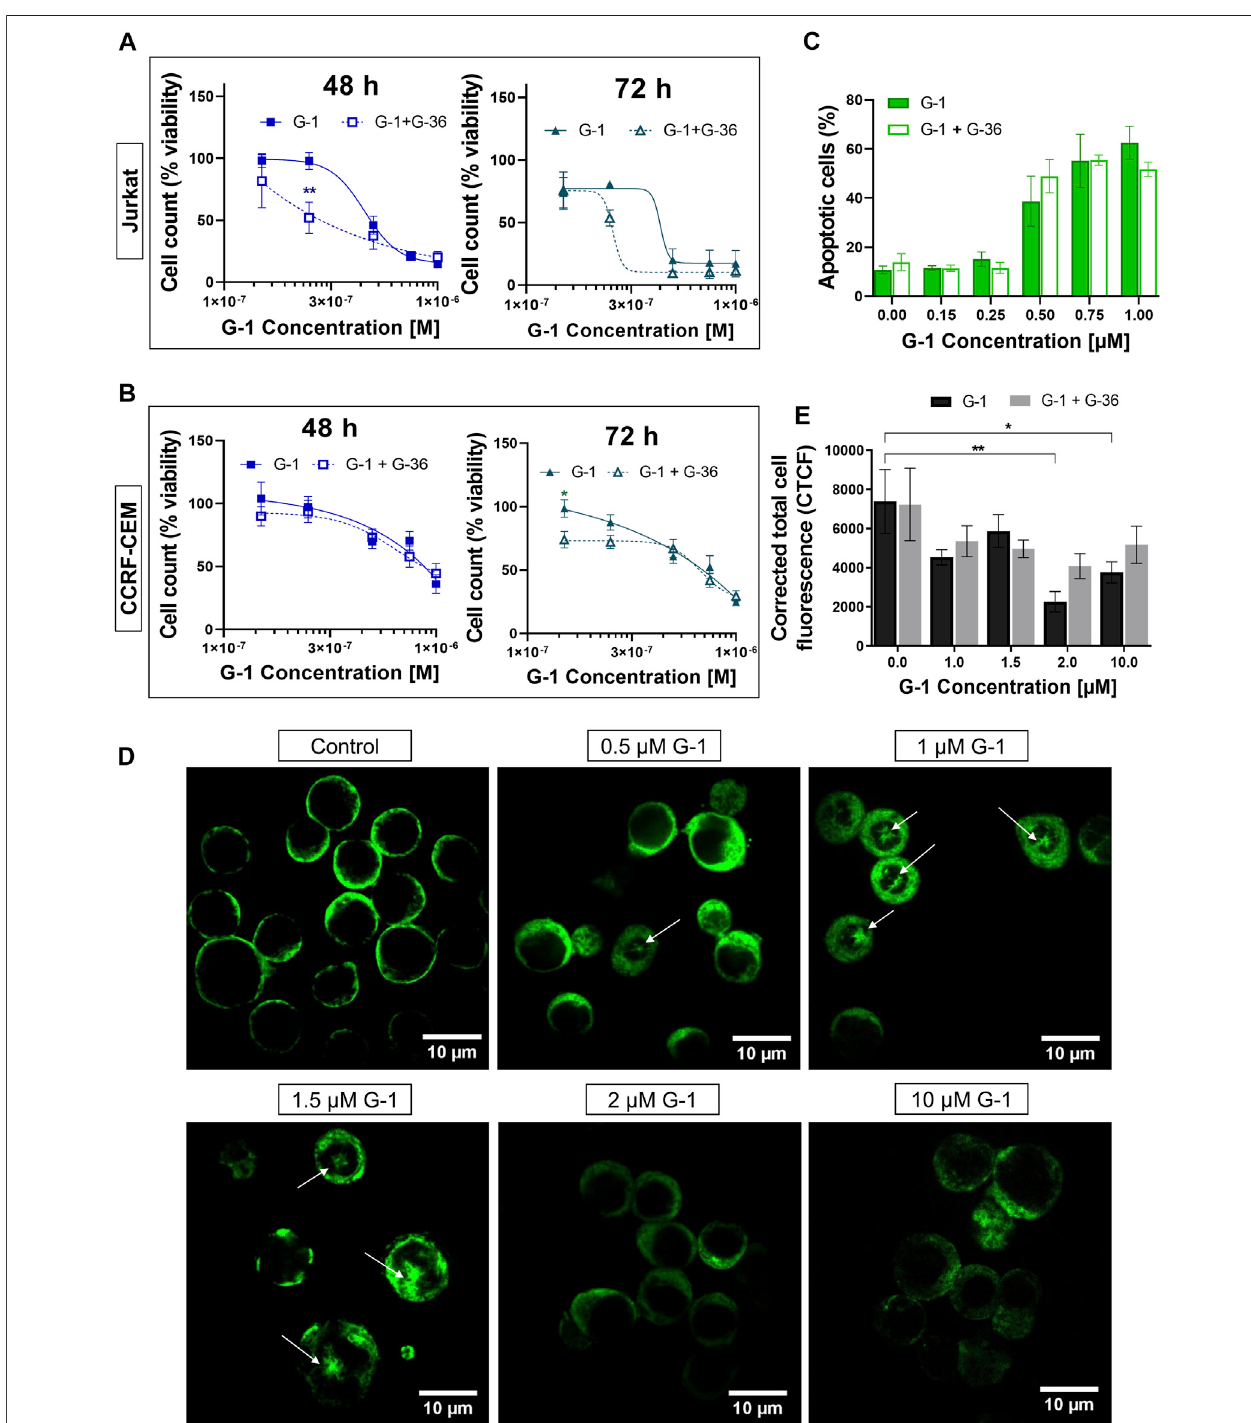
FIGURE2| G-36doesnotpreventantileukemiceffectsofG-1. (A,B) Jurkat (A) andCCRF-CEM (B) cellswerepre-incubatedwithG-36(10 μ M,30 min),seededin a growth medium containing different concentrations of G-1 and cultivated during indicated periods of time. Cell viability was evaluated by cell count (trypan blue exclusion test) and graphed as function of G-1 concentration. Data are normalized to control and shown as mean ± SEM; N ≥ 3; * p < 0.05, ** p < 0.01. Comparison between G-1 (solid line) and G1 + G-36 (dashed line) was performed by two-way ANOVA with Sidak post hoc testing. (C) Percentage of apoptotic cells ( fl ow cytometry, Q3 population of Annexin V/AlexaFluor488 + PI − cells) at 24 h of treatment. Data are mean ± SEM; N ≥ 3; Comparison between G-1 and G-1 + G-36 groups wasperformedbytwo-wayANOVAwithSidak posthoc testing.Nostatisticaldifferencewasrevealed. (D) Immunostainingof α -tubulin(green)inJurkatcellstreatedwith